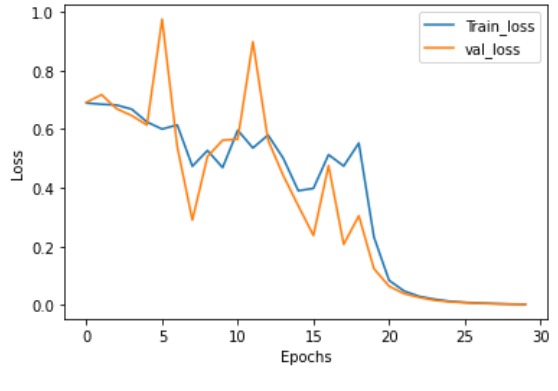
Figure 12. The loss curve. Table 2. Based on the experimental results of longitudinal features.